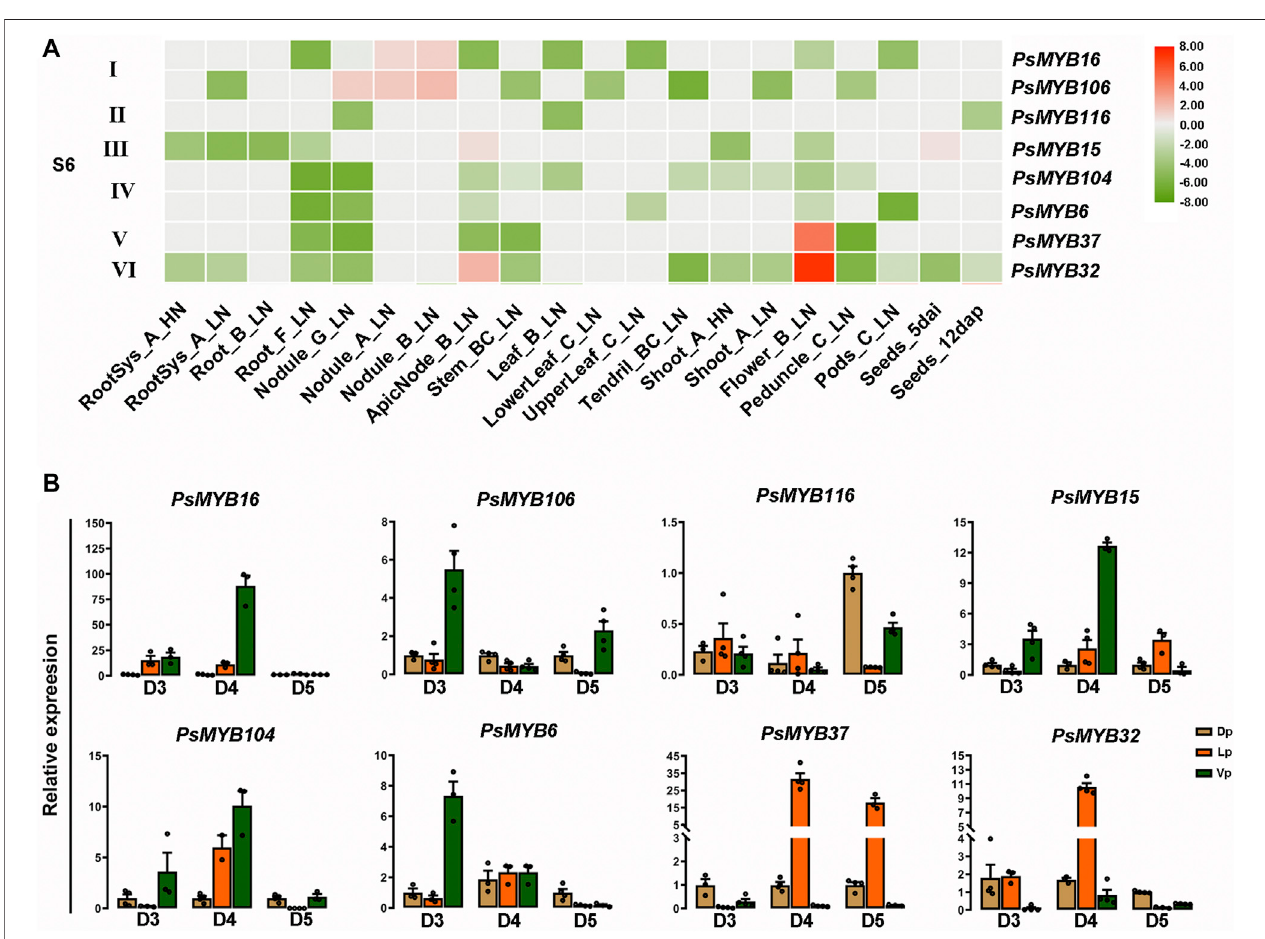
FIGURE6| Identi fi cationofR2R3-MYBcandidatesinvolvedinpigmentbiosynthesis. (A) Heat-mapshowingtheexpressionlevelofgenesfromS6subgroupunder differentnutritiveconditionsanddifferentstagesbasedonRNA-seq data.Normalizedlog2transformedvalueswereusedwithhierarchicalclusteringrepresentedbythe color scale ( − 9 – 8). Green indicates low expression, and red indicates high expression. HN, High N (14 mM N). LN, Low N (0.625 mM N). (B) The expression pro fi les of S6 R2R3-MYB family during fl ower development were con fi rmed using qRT-PCR. The data are the mean ± SD from three biological replicates. Dp, Dorsal petals; Lp, Lateral petals; Vp, Ventral